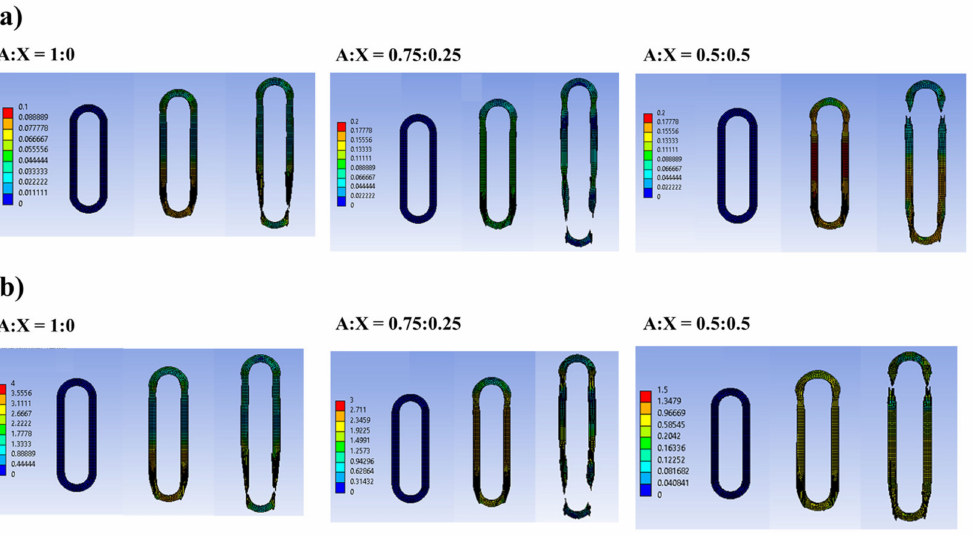
Figure 5. Simulation results of sample elongation and failure examined by a ring tensile test. ( a ) strain distribution, and ( b ) stress distribution in the sample during ring tensile measurement. A is agarose and X is